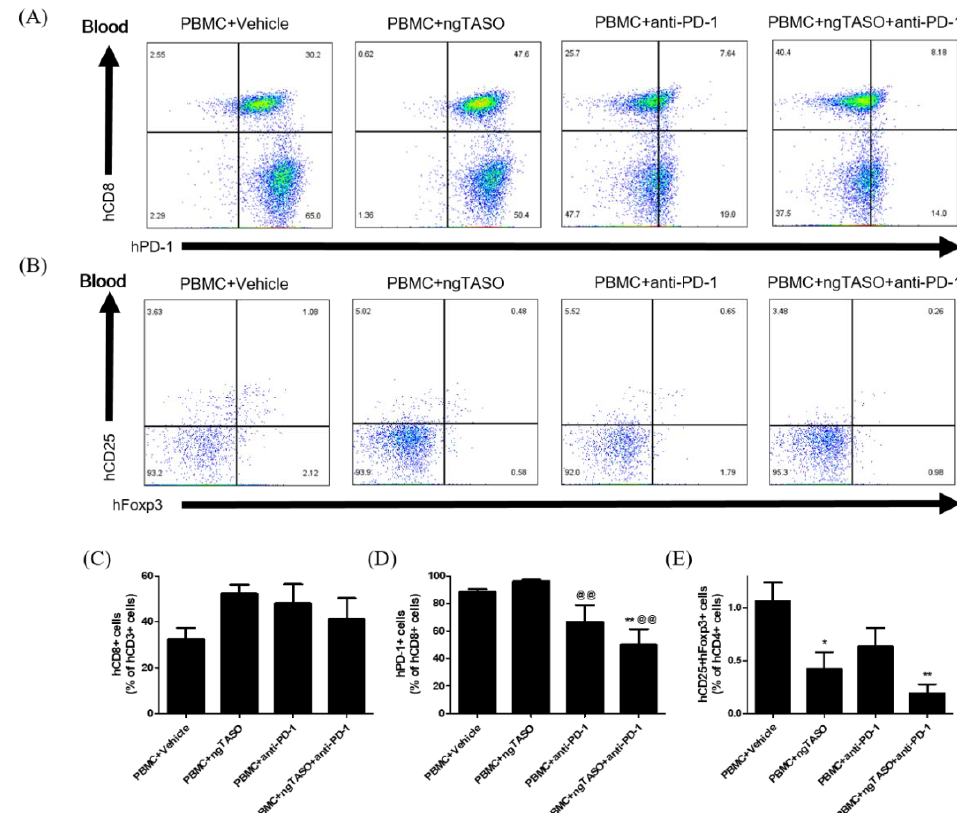
Figure 3. Effects of ngTASO and anti-PD-1 co-treatment on reconstitution of T cell subsets in peripheral blood. Subpopulations of human T cells in peripheral blood of hu-PBL NSG-B2m mice were measured by FACS analysis on day 21. ( A ) The representative flow cytometry plots of human CTLs (hCD8+PD-1+ cells) in the hCD3+-gated population and ( B ) human Tregs (hCD25+hFoxp3+ cells) in the hCD4+-gated population in peripheral blood of hu-PBL NSG-B2m mice. Data showing the percentage of ( C ) hCD8+ cells among hCD3+ cells, ( D ) hPD1+ cells among hCD8+ cells, and ( E ) hCD25+hFoxp3+ cells among hCD4+ cells. The results are expressed as mean ± S.E.M. obtained from five to six mice per group. * p < 0.05 and ** p < 0.01 vs. PBMC+Vehicle group; @@ p < 0.01 vs. PBMC+ngTASO group (Dunnet’s test). h, human.